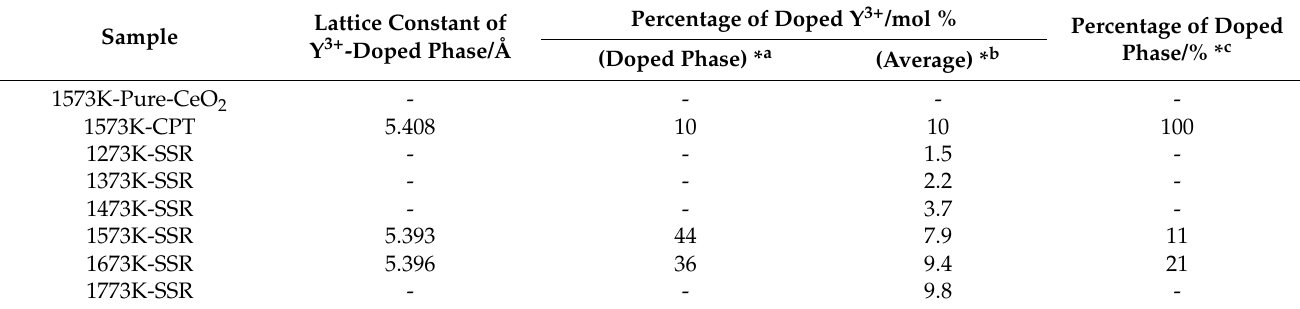
Table 1. Lattice constant of doped phase, percentage of doped Y 3+ in CeO 2 and percentage of doped phase. Lattice Constant of Sample Y 3+ -Doped